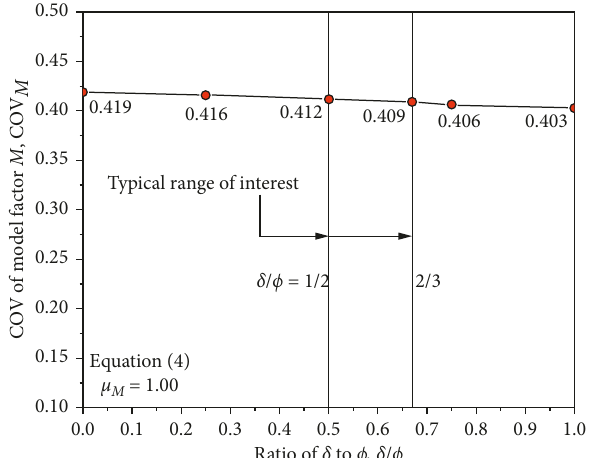
1.45; b (cid:31) (cid:31) −